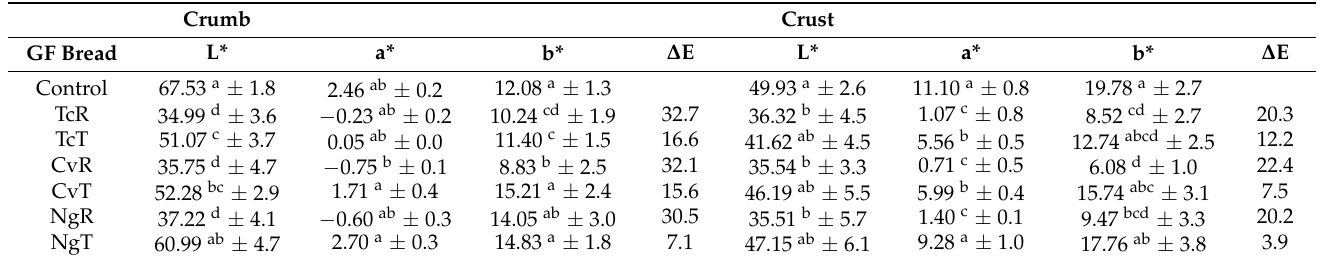
Table 6. Bread crumb and crust color parameters. Tetraselmis chuii (TcR), Tetraselmis chuii ethanol- treated (TcT), Chlorella vulgaris (CvR), Chlorella vulgaris ethanol-treated (CvT), Nannochloropsis gaditana (NgR), and Nannochloropsis gaditana ethanol-treated (NgT).